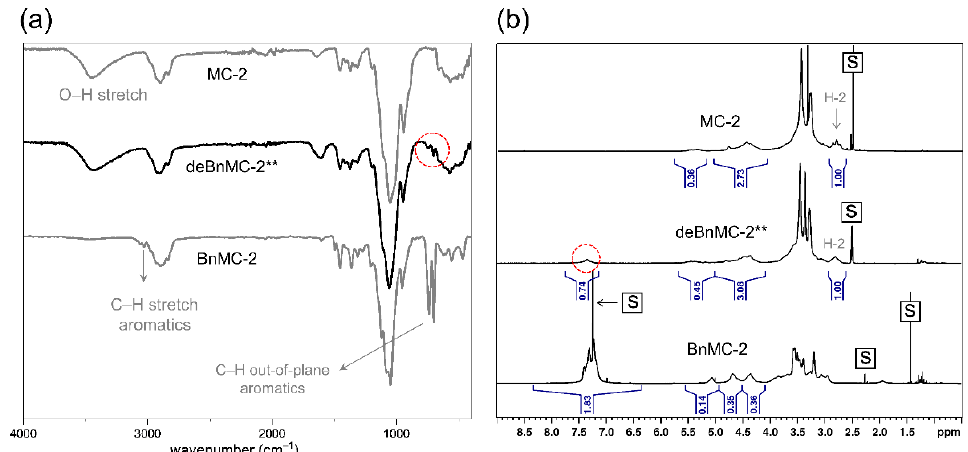
Figure 7. ( a ) The ATR-IR spectra of deBnMC-2** (Table 1, Method-2b), MC-2, and BnMC-2. ( b ) The 1 H NMR spectra of MC-2 (600 MHz, DMSO- d 6 ), deBnMC-2** (300 MHz, DMSO- d 6 ), BnMC-2 (600 MHz, CDCl 3 ). S-labeled squares indicate residual solvents peaks. The peak of the residual aromatic groups is shown by the dashed-line circle.